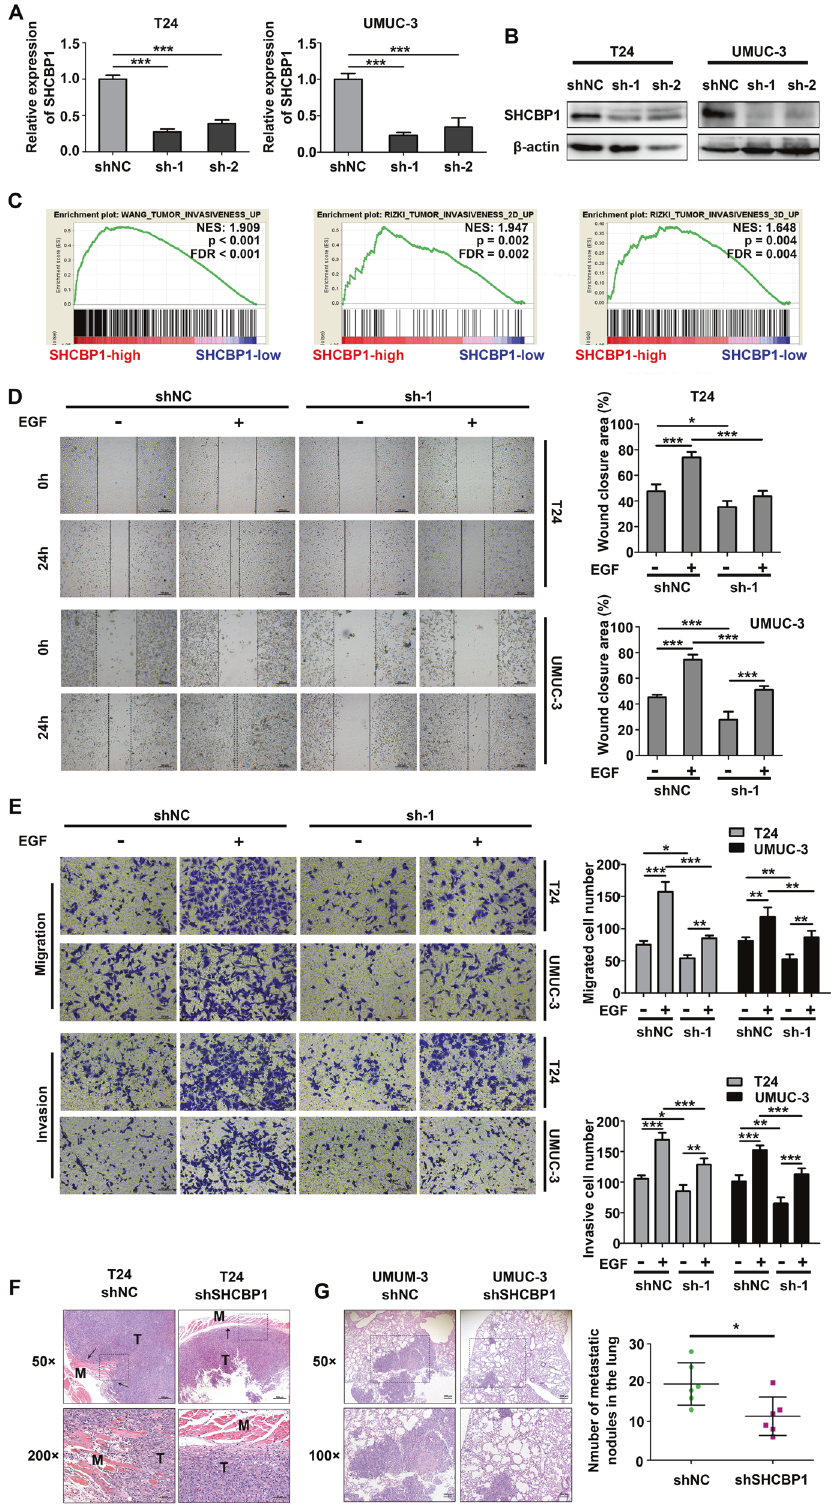
Fig. 3 SHCBP1 is involved in EGF-induced cell migration and invasiveness in bladder cancer. A , B RT-qPCR and immunoblotting analysis showing SHCBP1 expression in the indicated cells transfected with shNC or shSHCBP1. ** p < 0.01 and *** p < 0.001. C GSEA indicating that SHCBP1 expression was positively associated with tumor invasiveness (data from TCGA). D Scratch assays indicating the effect of SHCBP1 depletion on EGF-induced motility of T24 and UMUC-3 cells. * p < 0.05 and *** p < 0.001. E Transwell assays showing the effect of SHCBP1 depletion on EGF-induced migration and invasion of T24 and UMUC-3 cells. * p < 0.05, ** p < 0.01 and *** p < 0.001. F H&E staining of both the tumor tissue and muscle tissue in the subcutaneous tumors xenografted with the indicated cells. Black arrows point to the direction of tumor invasiveness. G H&E staining of metastatic lesions in the lungs of mice injected with the indicated cells for 6 weeks. The number of metastatic nodules was calculated for each group ( n = 6) in the panel. * p < 0.05. Cell Death and Disease (2022)